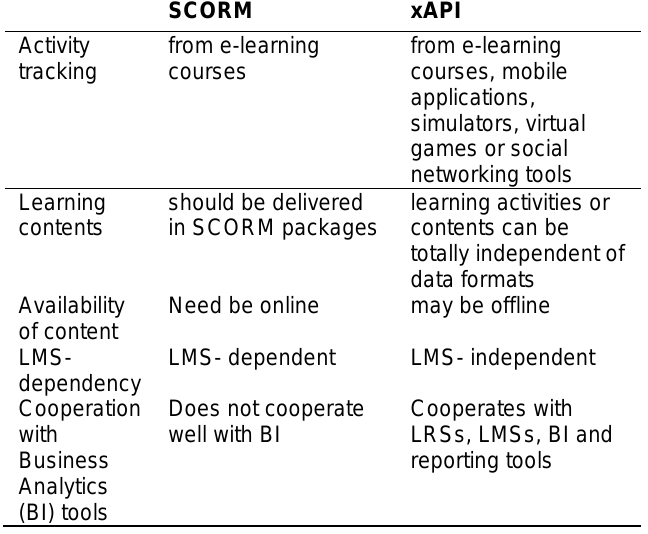
Table 1. The main differences between xAPI